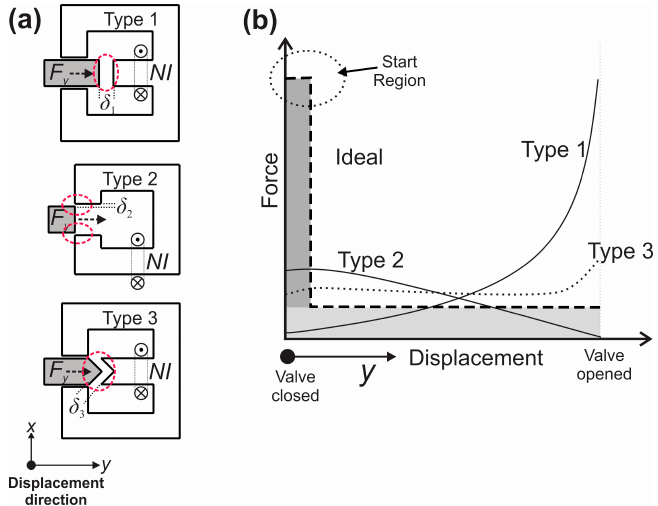
Figure 1. ( a ) Conventional electromagnetic valve actuators. ( b ) The comparison of the force-displacement curve shapes obtained with three di ff erent types of actuators Type 1, Type 2, and Type 3 with the ideal one (within Ideal operating area-grey area, ideal force-displacement curve-dashed line).